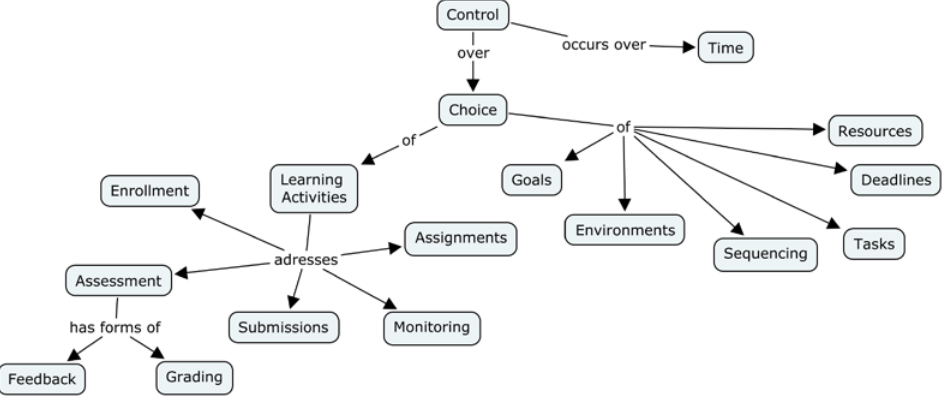
Figure 1 . Model of teacher control in the context of formal